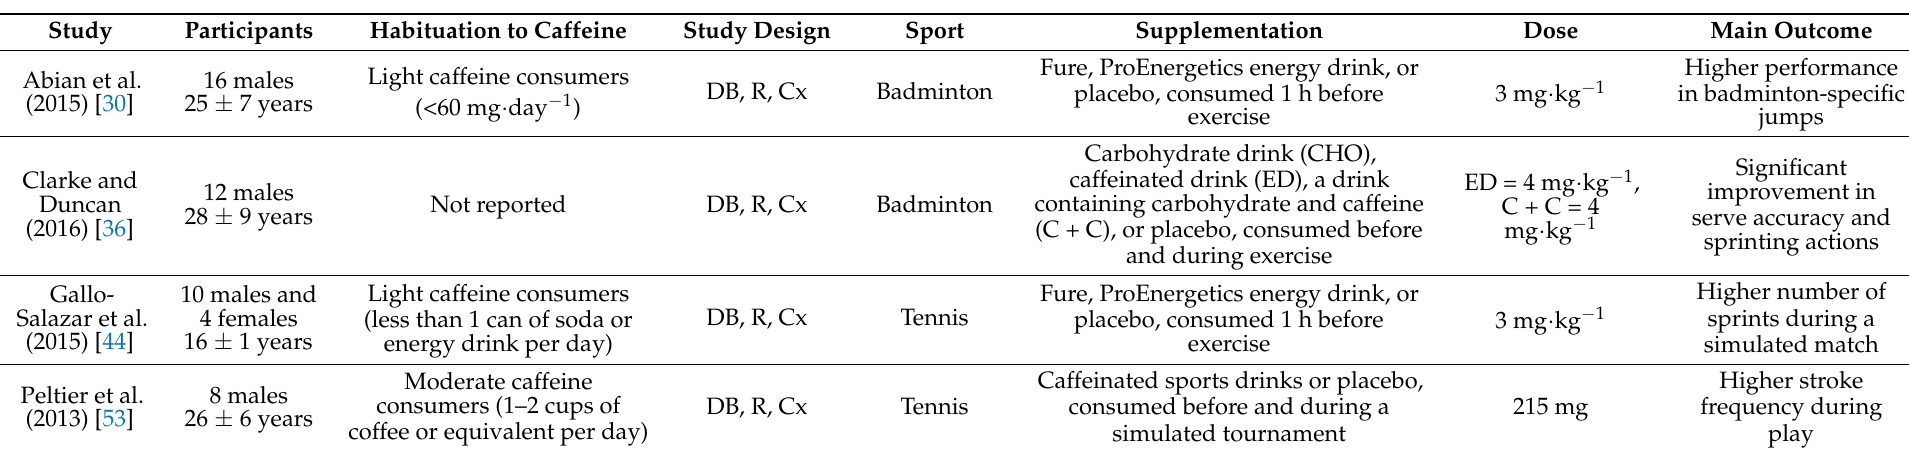
Table A4. Investigations in mixed-metabolism individual